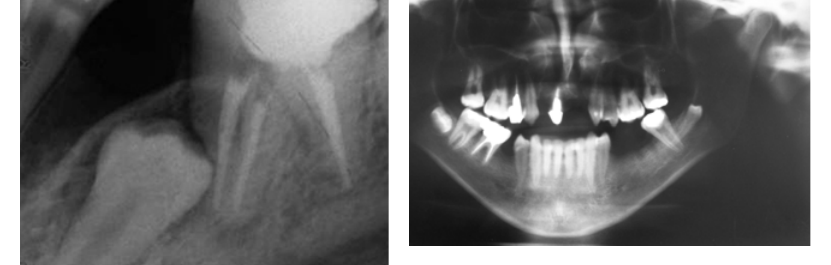
FIGURE 6- Two months after extraction of the mandibular left 1st molar at the age of 15